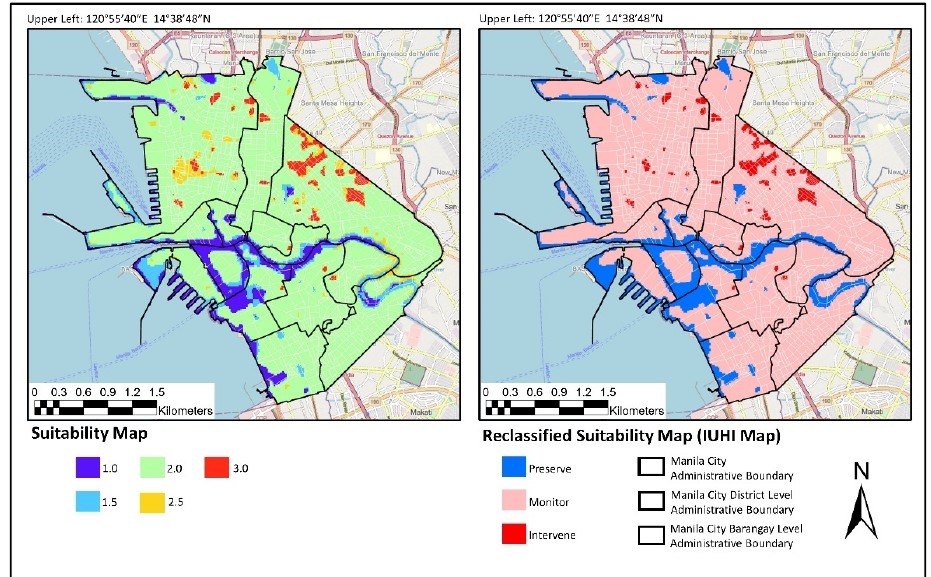
Figure 12. Suitability Map and the reclassified suitability (IUHI) map with the corresponding new class.